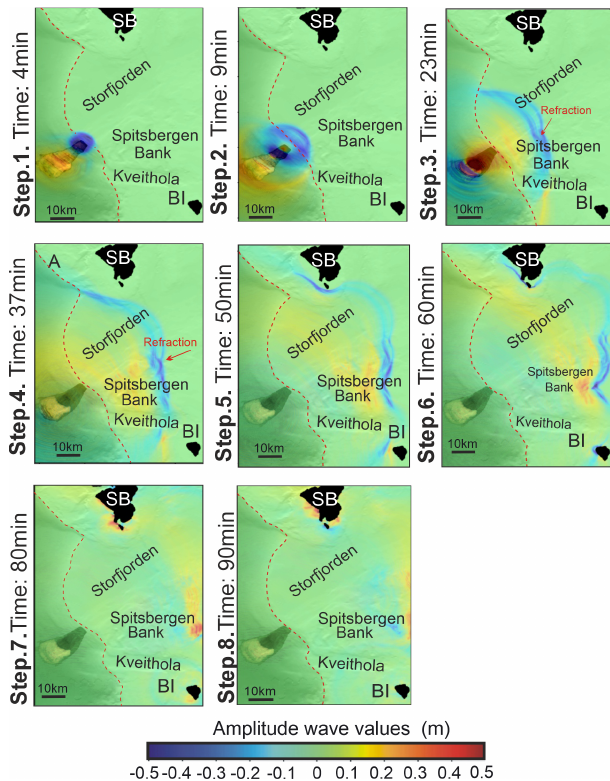
Figure 8. Eight steps displaying the tsunami waves generated at dif- ferent times. The dotted red line indicates the shelf break. The first step shows the generation of the tsunami wave and its spread. At 23min the outgoing wave suffers refraction. At 50min the tsunami wave arrives at the northern coast of Spitsbergen and Bear Island, and at the 60min, it hits the westernmost coast of